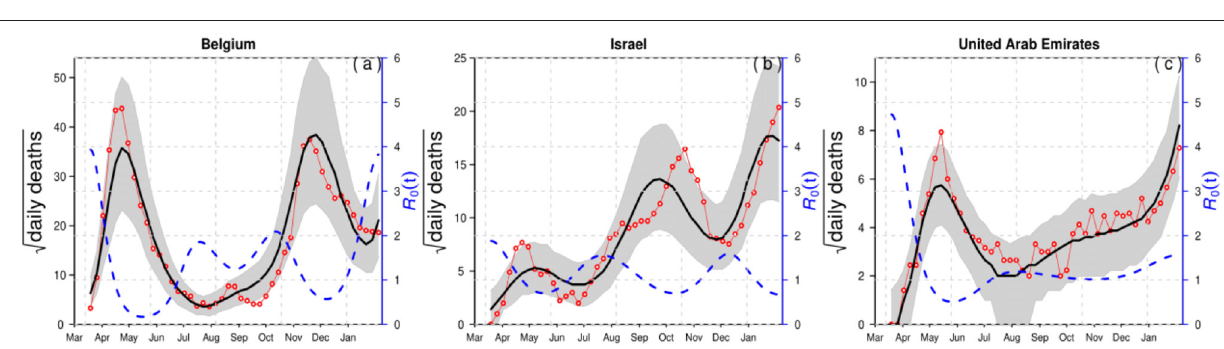
FIGURE 3 | Time-series fitting results of daily confirmed COVID-19 deaths (in red circled) in (a) Belgium, (b) Israel, and (c) the United Arab Emirates represented, respectively. The medium of the simulation is represented by the black curve, and the time-varying effective reproduction number [ R 0 ( t )] is denoted in the blue dashed curve. The 95% confidence interval of the simulation is shown by the shaded (gray) region. The mean LP = 3 days and the mean IP = 6